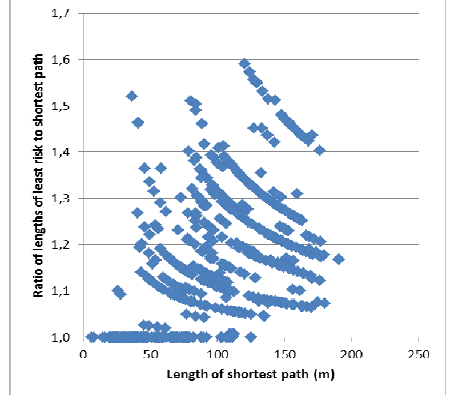
Figure 7: Graph of the ratio of least risk on shortest path length to the shortest path length